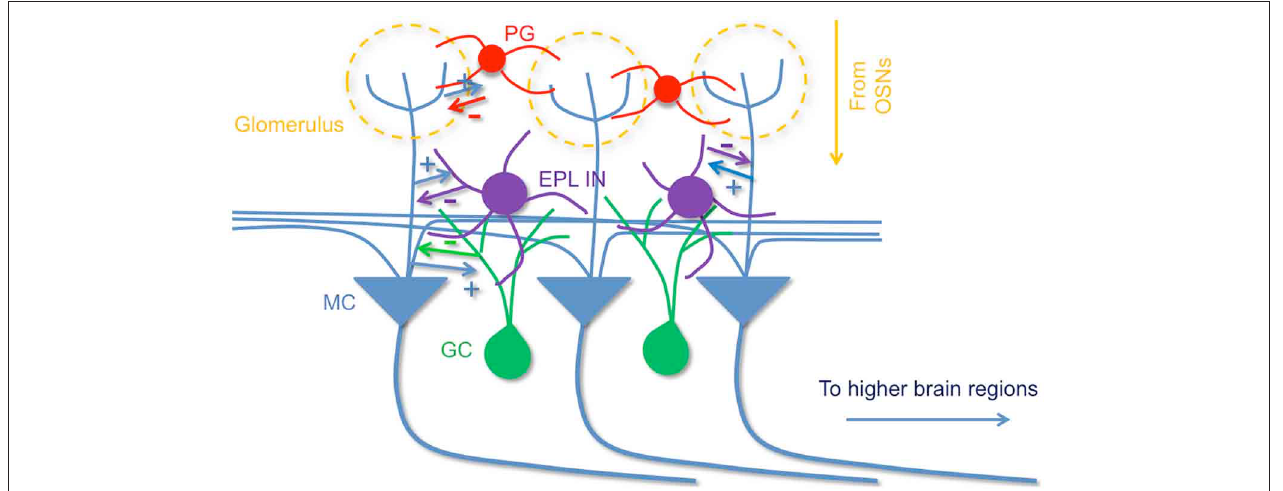
FIGURE 9 | A model of olfactory bulb circuitry that includes EPL interneurons. Mitral cells receive odor input from sensory neurons at glomeruli and send output to higher brain areas. Periglomerular cells inhibit mitral cells at their apical dendrites within the GL layer, and local granule cells provide inhibition onto mitral cells via dendrodendritic synapses in EPL layer. In addition to granule cells,